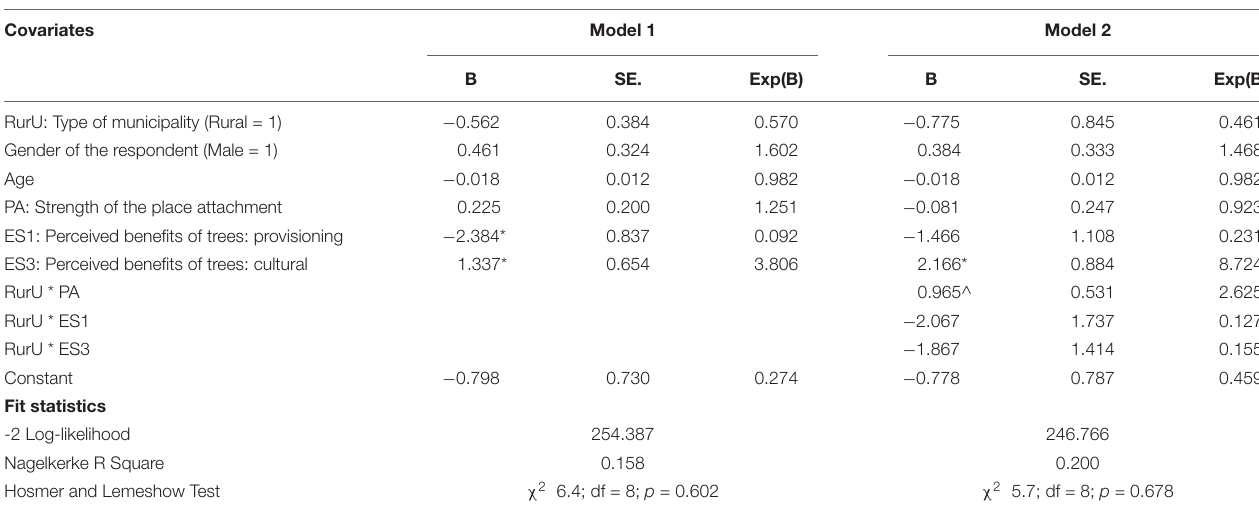
TABLE 2 | Logistic regression